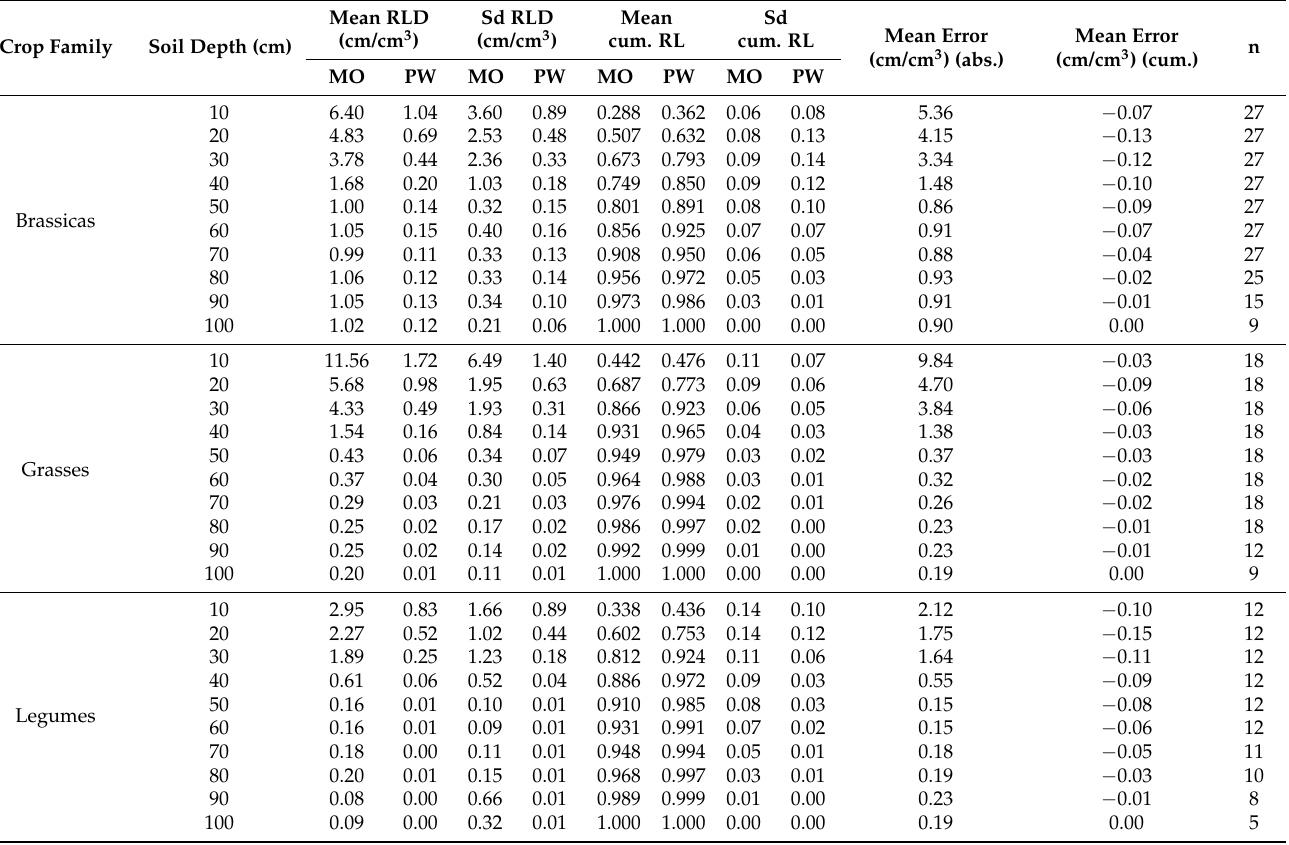
Table 2. Descriptive statistics of root-length density (RLD) measurements from profile wall (PW) and monolith (MO) methods for different crop categories and soil depths. Mean RLD is the mean value in cm/cm 3 of all RLD absolute values, and Sd RLD is the standard deviation in cm/cm 3 of all RLD absolute values. Mean cum. RL is the mean cumulative root-length distribution and Sd cum. RL is the standard deviation of the mean cumulative root-length distribution. Mean error is the mean difference between MO and PW. n is the number of observations for each